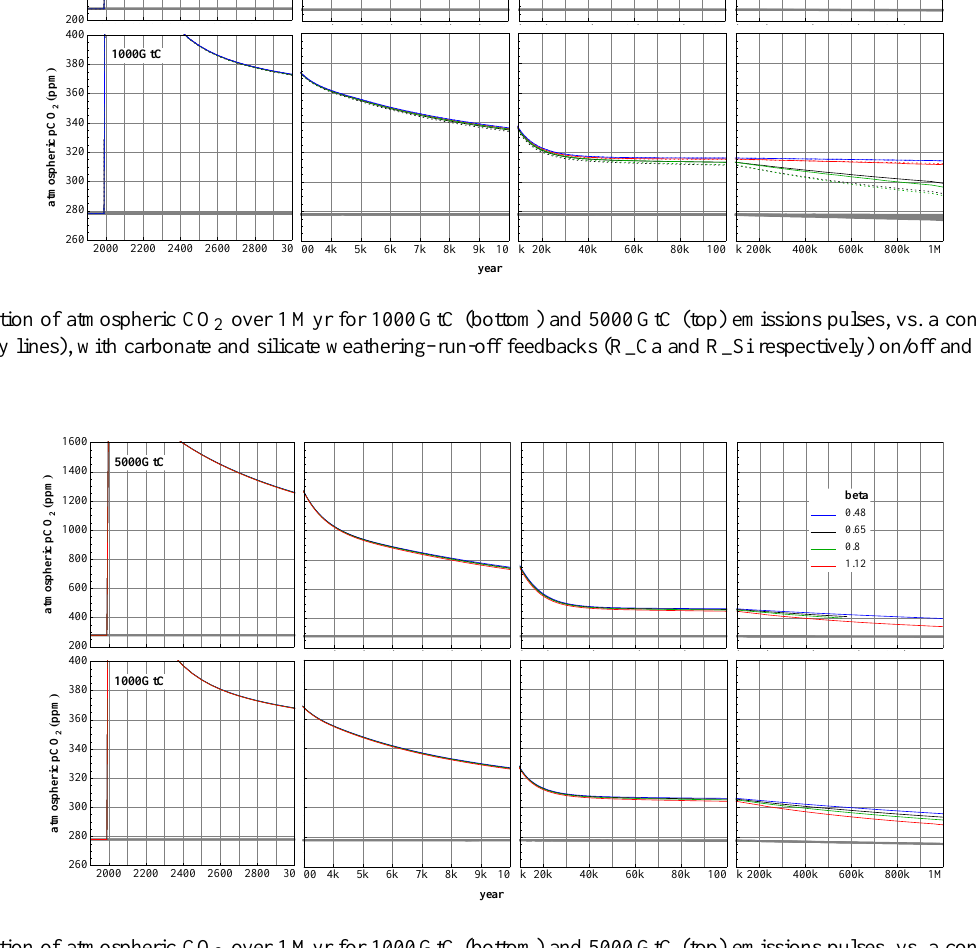
Fig. 11. Evolution of atmospheric CO 2 over 1 Myr for 1000 GtC (bottom) and 5000 GtC (top) emissions pulses, vs. a control run with no emissions (grey lines), with different values of runoff fractional power dependence.